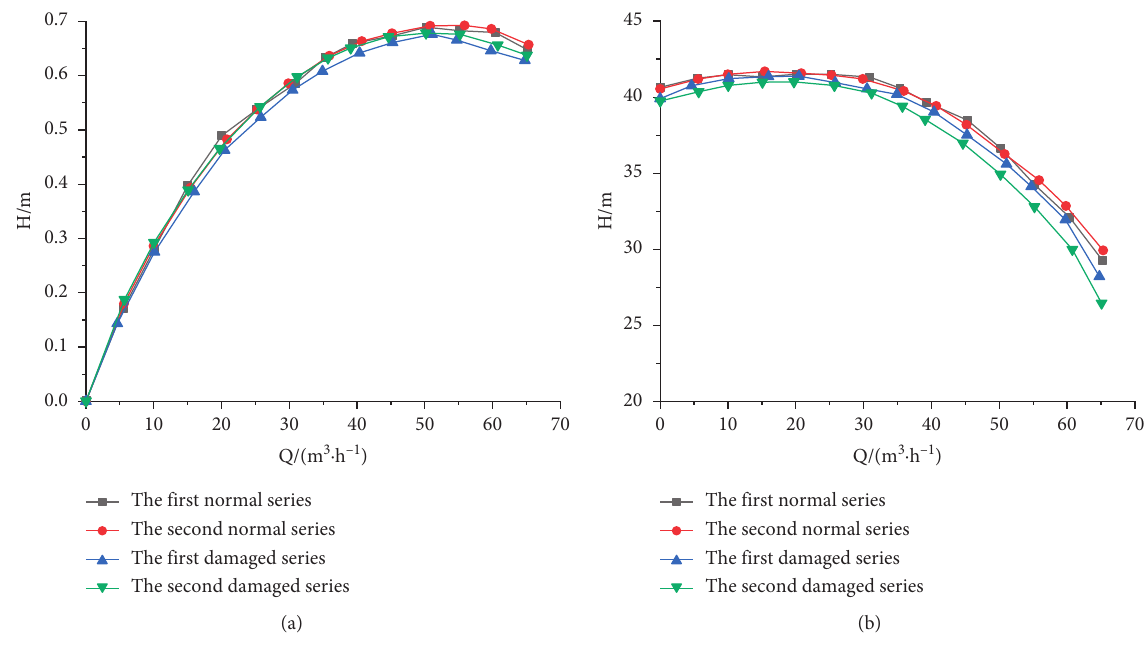
Figure 2: Test device. (a) Head diagram. (b) Efficiency